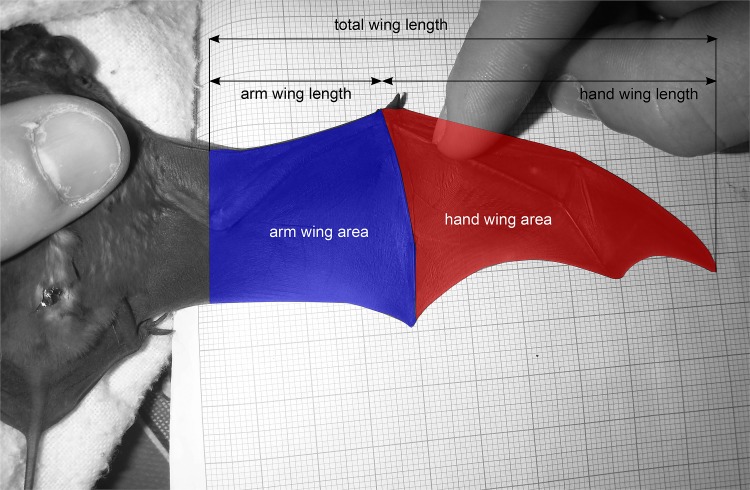
Right wing of a Molossus molossus showing areas used to analyze wing shape.